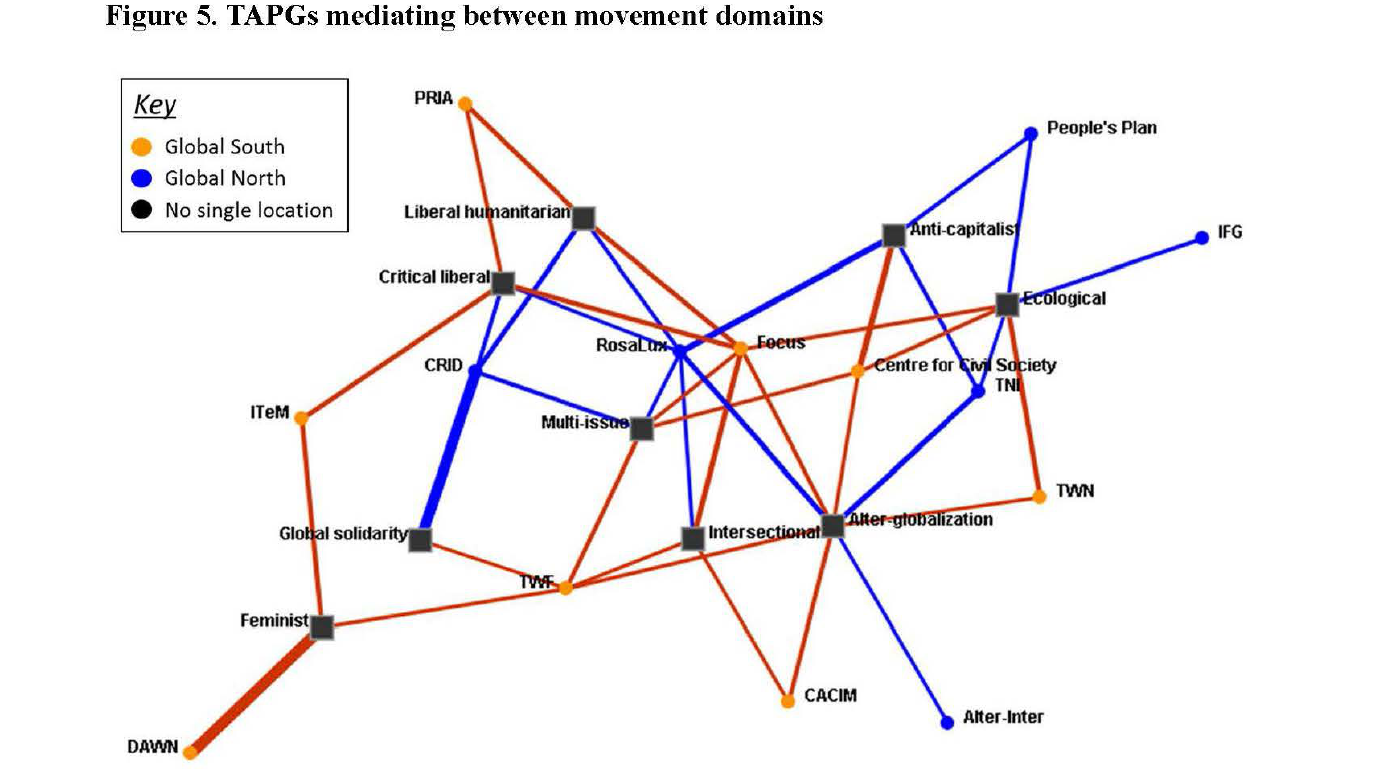
Figure 5. TAPGs mediating between movement domains